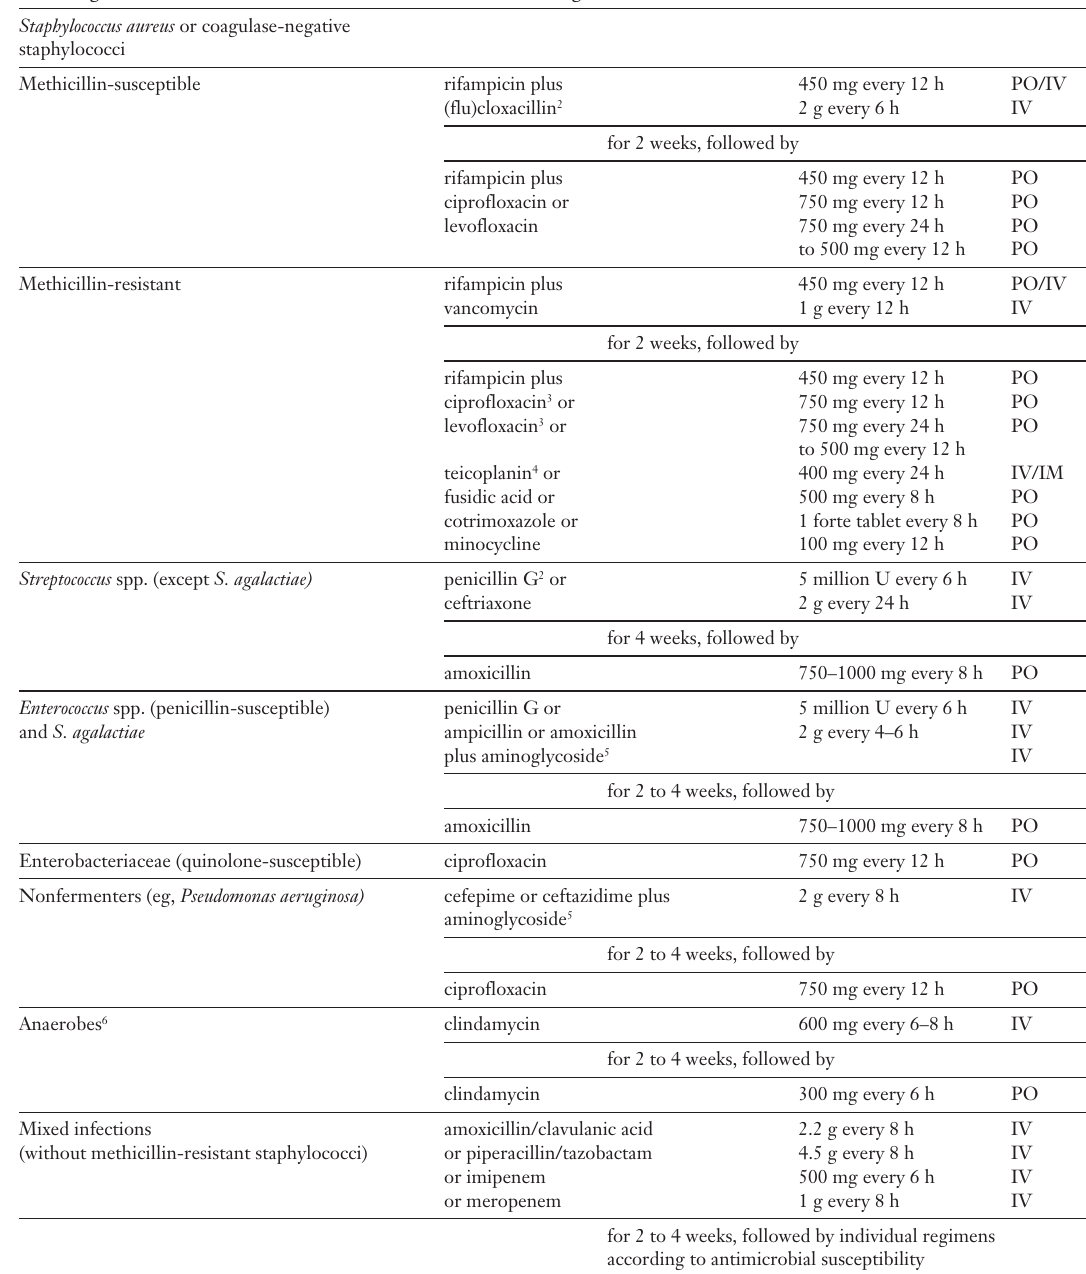
Treatment of pros- thetic joint infections (adapted after Zimmerli et al.